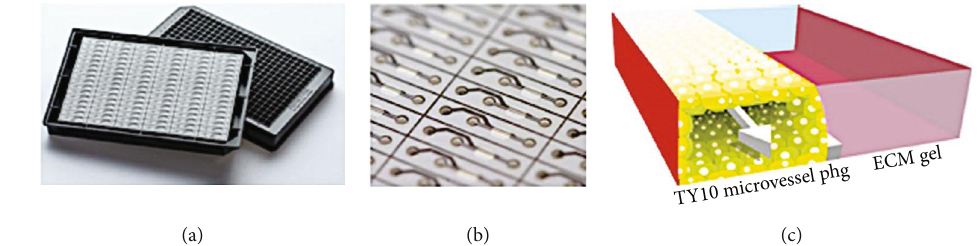
Figure 26: OrganoPlate device platform. (a) Schematic of the two-lane OrganoPlate. (b) Zoom-in of the bottom of the two-lane OrganoPlate. (c) 3D schematic of the chip. Reproduced (or adapted) with permission [131], ©2018,